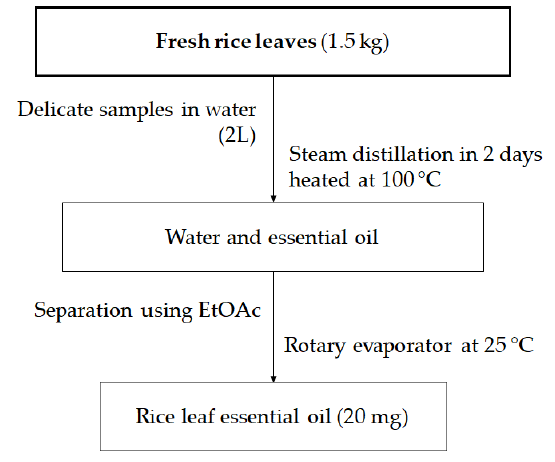
Figure 2. Process of rice leaf essential oil extraction.